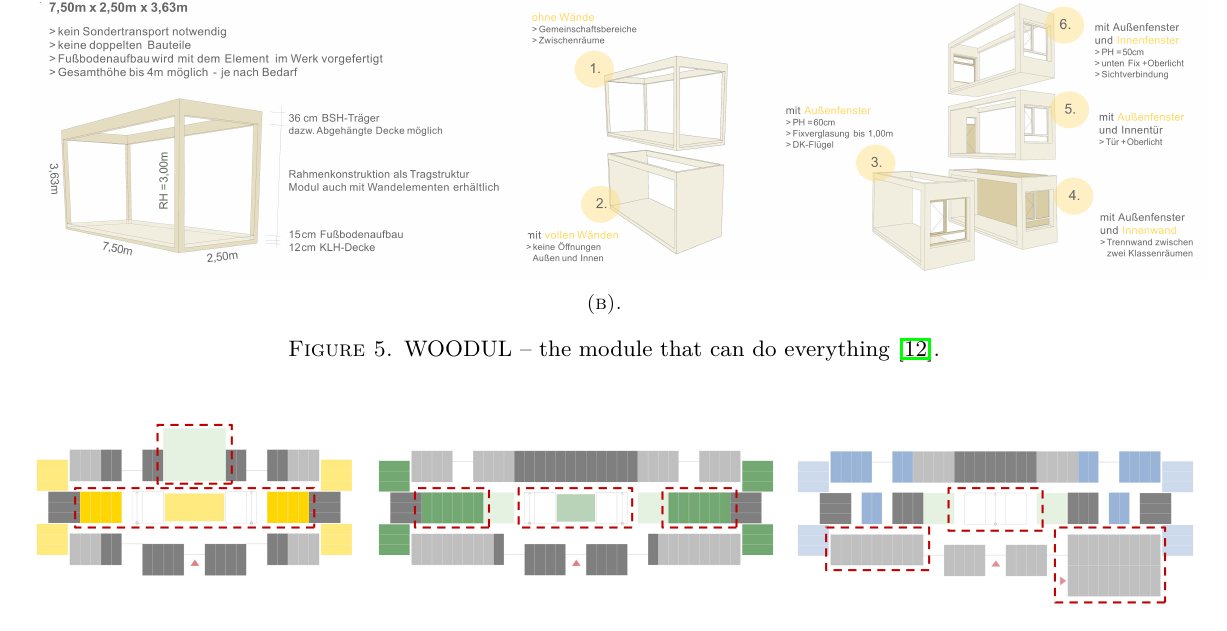
Figure 6. Building types: Kindergarten / Compulsory school / University (from left to right)